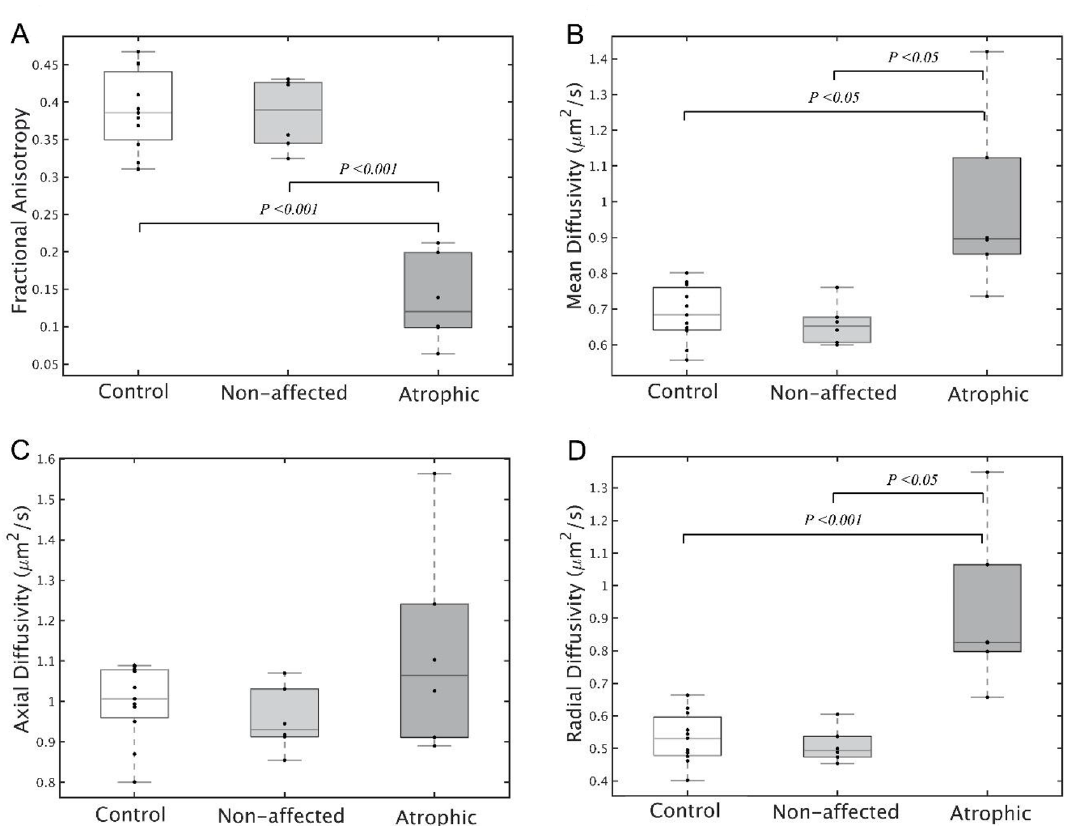
Figure 3. Comparison of diffusion measures of atrophic optic nerves (ONs) to those of non-affected ONs and control ONs. Comparison of averaged optic nerve fractional anisotropy (FA) ( A ), mean diffusivity (MD) ( B ), axial diffusivity (AD) ( C ), radial diffusivity (RD) ( D ) in controls (n = 11) and patients (n = 6) with the light gray boxplot for non-affected eyes and dark gray boxplot for eyes with atrophic optic nerves. On each box, the central mark is the median, the edges of the box are the 25th and 75th percentiles, and data points are plotted individually. Significant differences are denoted by the marked line with the